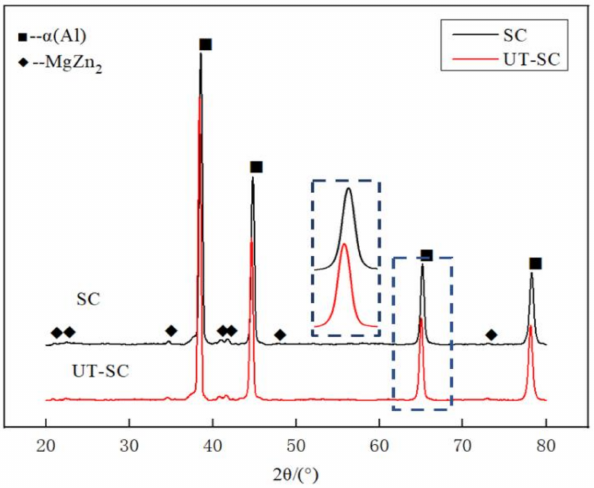
Figure 9. XRD patterns of SC and UT-SC for alloy